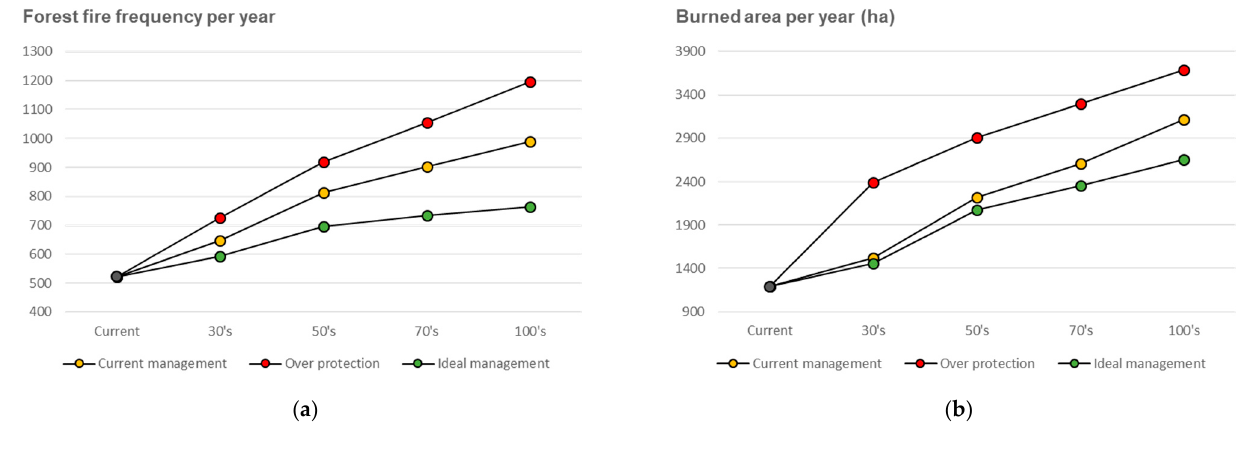
Figure 16. Future projection of forest fires by the optimized FLAM based for the forest management scenario [26]: ( a ) forest fire frequency per year, ( b ) burned area per year.